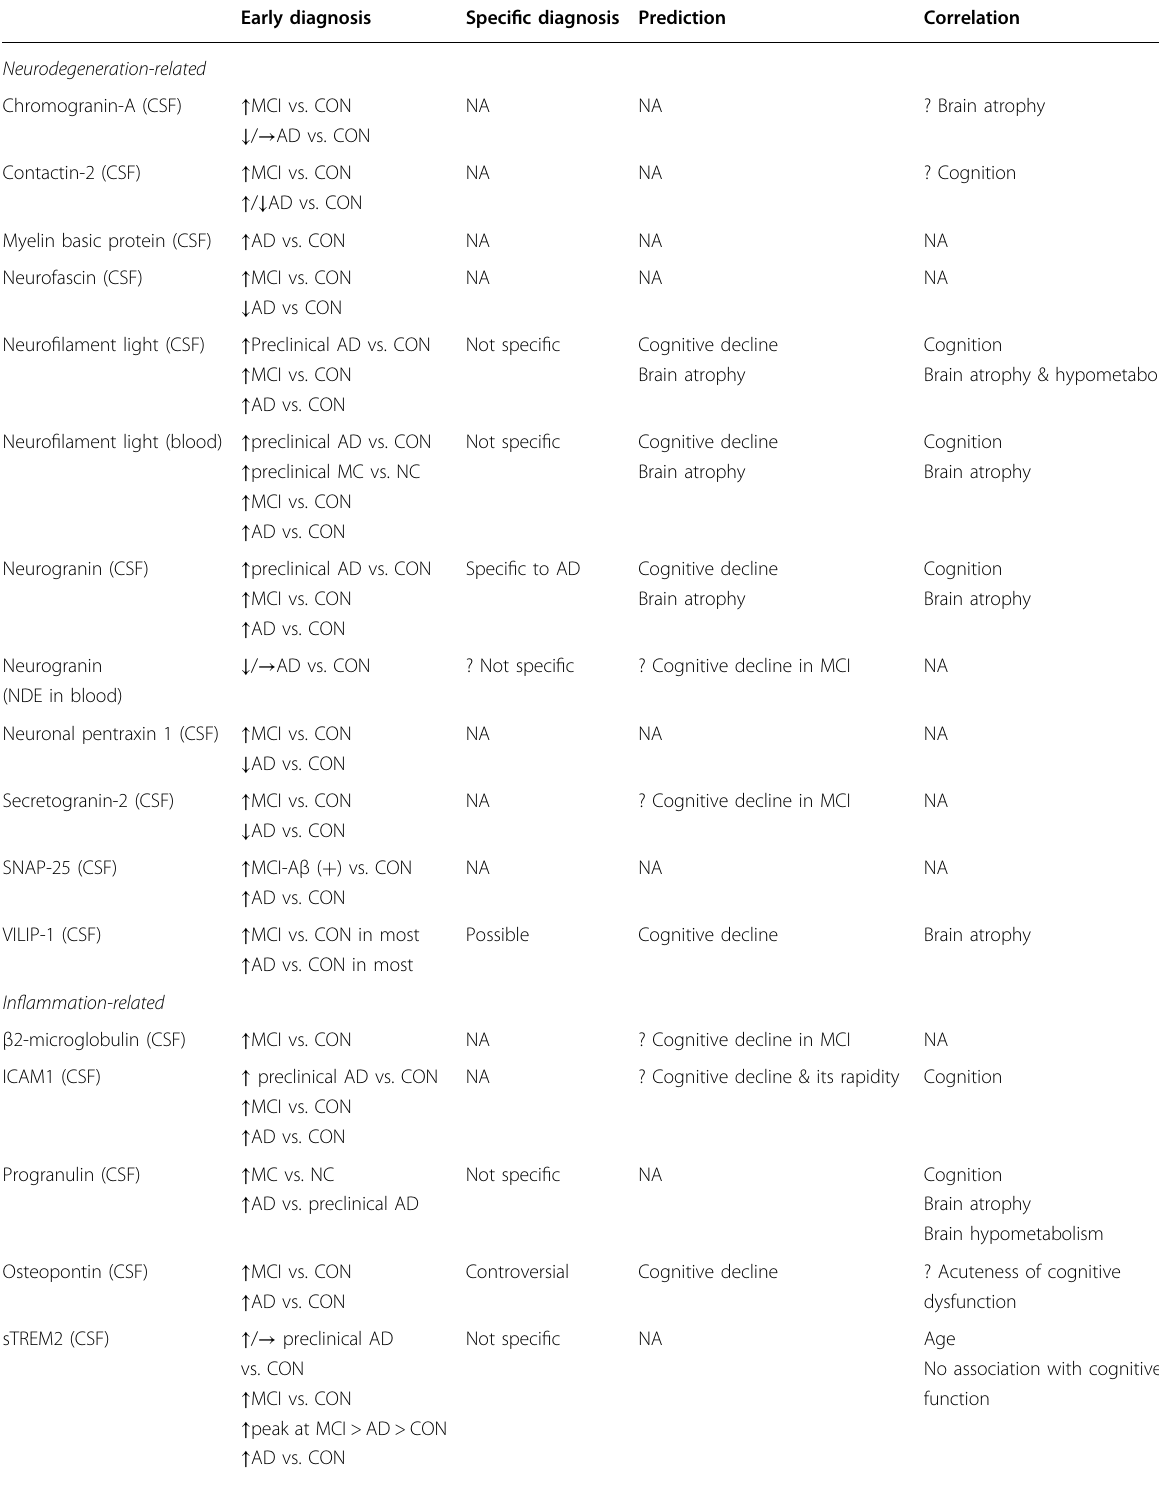
Table 1 Utility of new fl uid biomarkers in Alzheimer ’ s